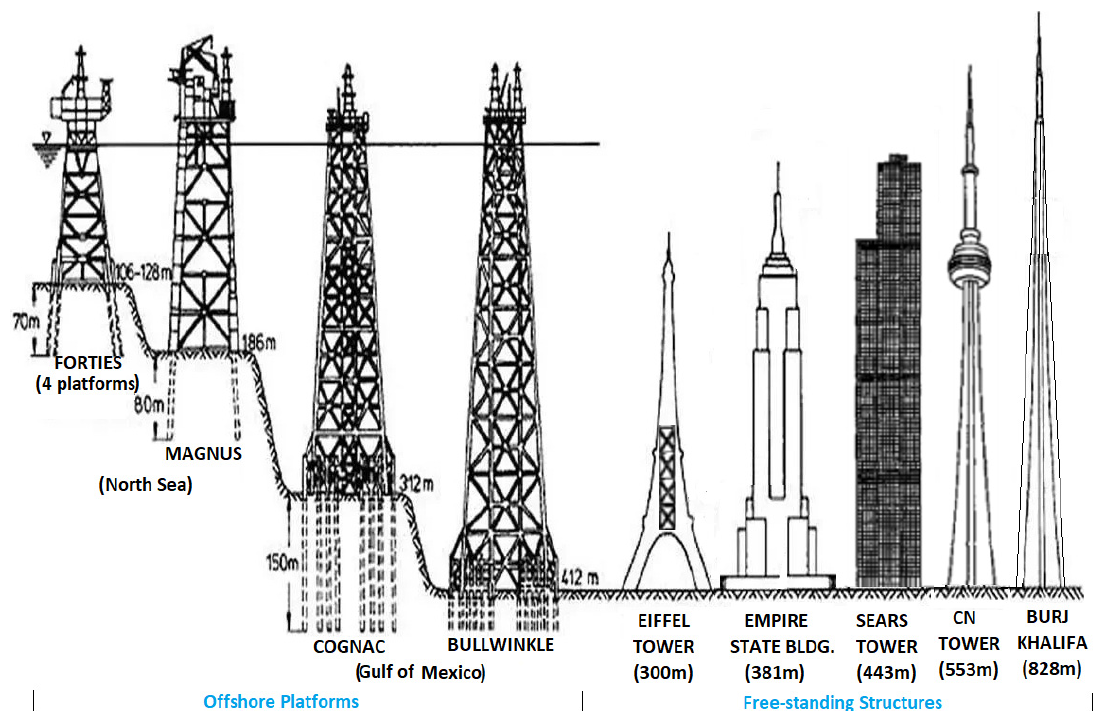
Figure A1. Typical structures for asset integrity management, and monitoring. It shows the comparative height of the tallest free-standing structures against the offshore platform [Credit: C.V.A.].